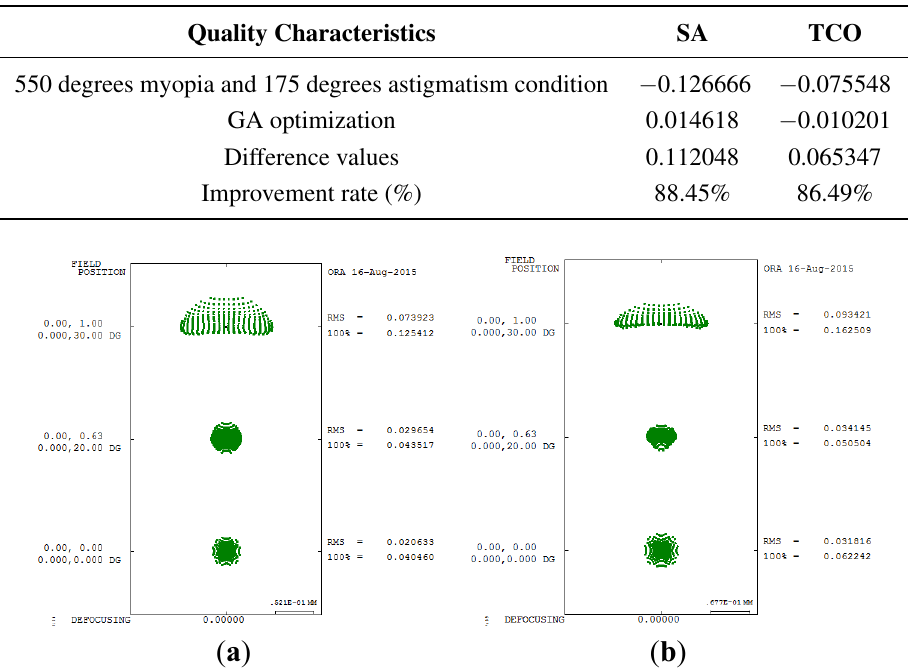
Figure 12. Spot size diagram after applying the GA optimization method. ( a ) 5 mm; ( b ) 6 mm.